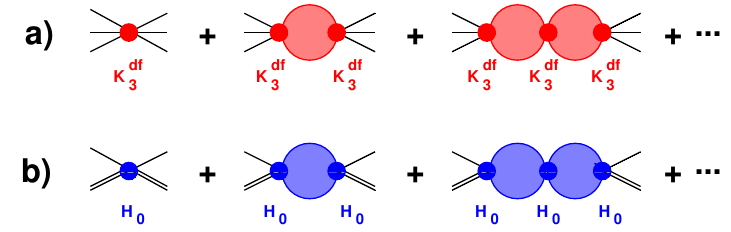
Figure 7 . a) The three-particle Green function and b) The particle-dimer Green function: insertion of the three particle/particle-dimer couplings. The shaded blobs contain only self-energy insertions and particle \hopping," see (cid:12)gure 8.